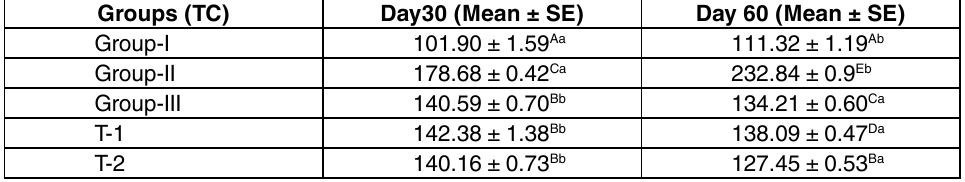
table 6. The mean ± SE serum cholesterol (mg/dl) values in different treatment